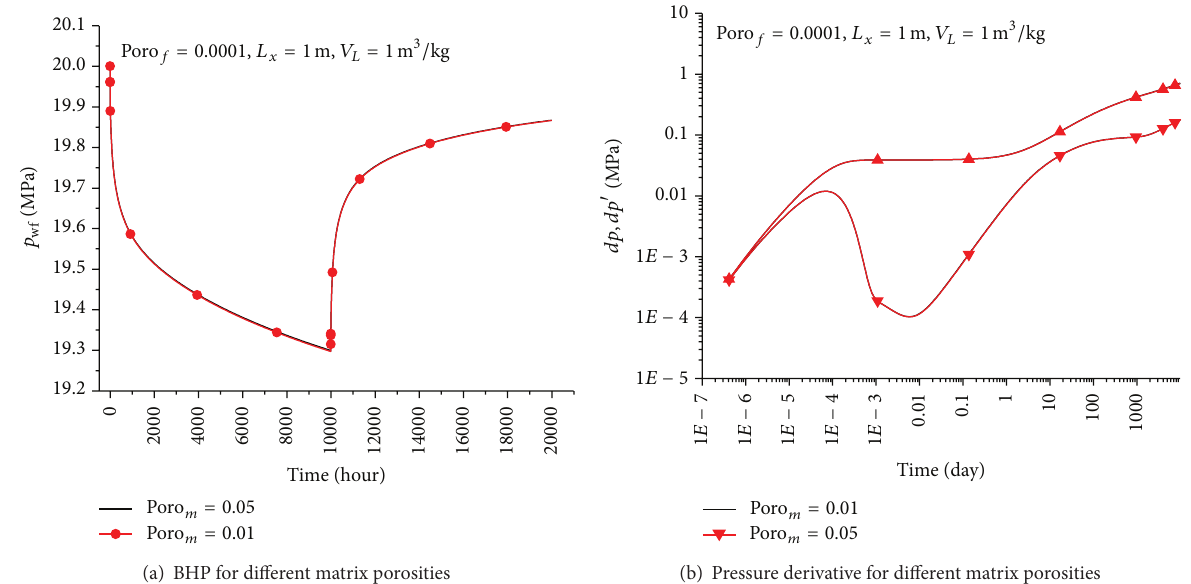
Figure 7: Effect of matrix porosities on pressure response for 𝑉 𝐿 = 1 m 3 / Kg, 𝐿 𝑥 = 1 m, and 𝜑 𝑓 = 0.0001